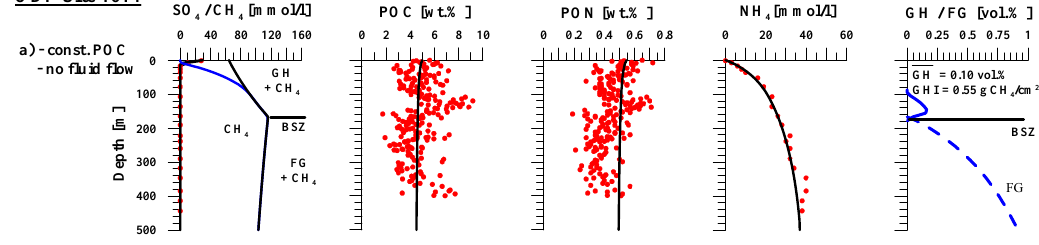
Fig. 5. Model results for ODP Site 1014 off California with (a) constant POC input. The dotted line indicates the free gas (FG) contents below the base of the GHSZ (BSZ) in % of the pore space.